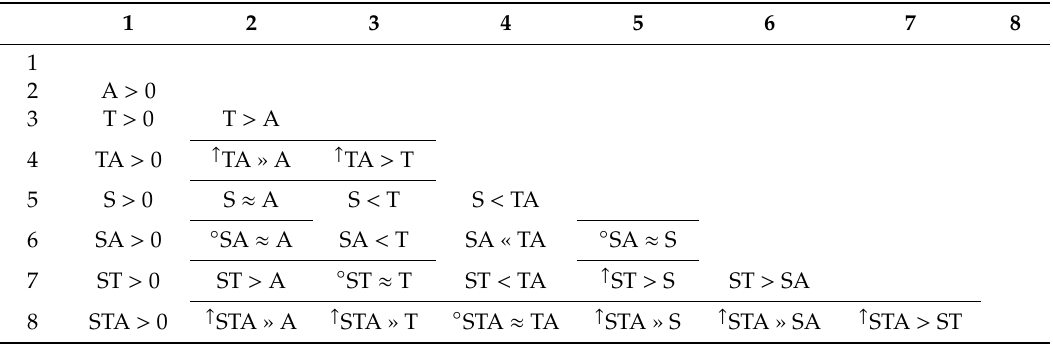
Table 8. Symmetric matrix of qualitative e ff